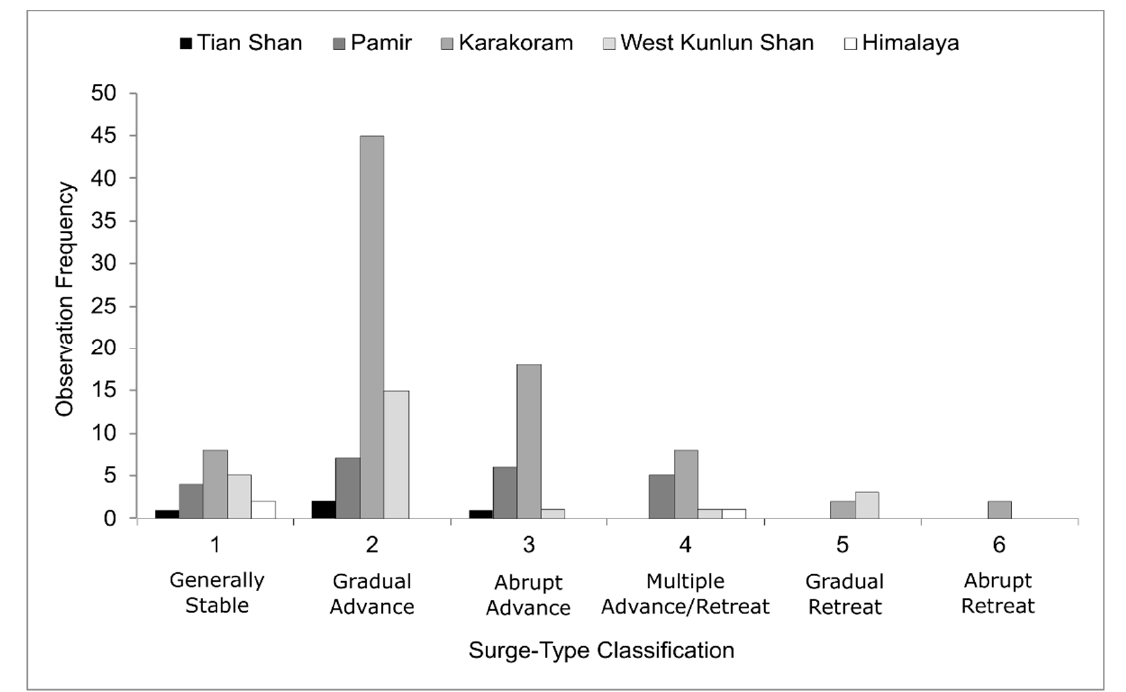
Figure 5. Sub-regional frequency of observations in each surge-type class.